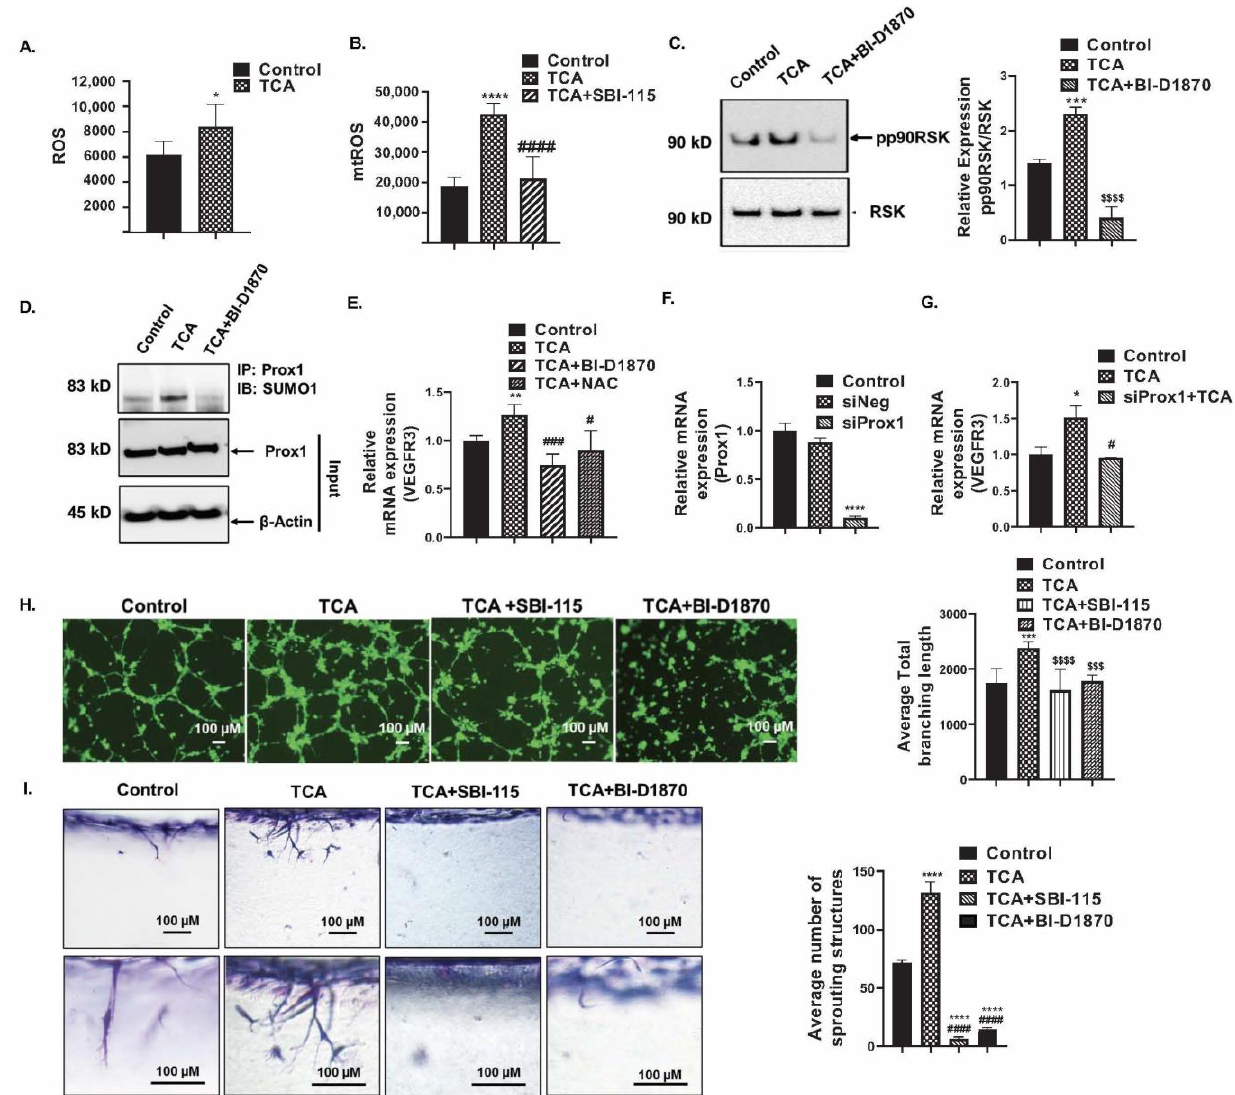
Figure 5. Conjugated BAs promote ROS production and induces p90RSK-mediated Prox1 SUMOy- lation and enhances VEGFR3. TCA (100 µM) induced ( A ) cellular ROS production at 45 min and ( B ) mtROS production after 12 h of treatment in HLEC, measured by fluorometric assay in plate reader. TGR5 antagonist SBI-115 (10 µM) pre-treatment for 1 h inhibited the TCA-induced mtROS produc- tion. ( C ) Western blot analysis showed that TCA (100 µM)-induced p90RSK phosphorylation in HLECs after 24 h, which was inhibited by p90RSK inhibitor BI-D1870. ( D ) After 24 h treatment with TCA (100 µM), the Prox1 was immunoprecipitated using anti-Prox1 antibody and probed with anti- SUMO1 antibody. TCA treatment induced Prox1 SUMOylation in HLECs which was inhibited by inhibition of p90RSK activation by using BI-D1870. ( E ) TCA (100 µM) induced VEGFR3 mRNA ex- pression which was inhibited by p90RSK inhibitor BI-D1870 and ROS inhibitor NAC. ( F ) Prox1 gene was knocked down in HLECs by siProx1 and ( G ) Prox1 knockdown inhibited the TCA-induced VEGFR3 expression. ( H ) TCA induced tube formation of HLECs in Matrigel at 4 h, which was in- hibited by the TGR5 antagonist SBI-115, p90RSK inhibitor BI-D1870. ( I ) TCA (100 µM) induced the HLEC invasion in 3D collagen matrix at 20 h and was inhibited by BI-D1870 or TGR5 antagonist SBI-115. Values represent mean ± SD n ≥ 3. Statistical analysis was done by ANOVA followed by Fishers LSD. *, **, ***, **** indicates p ≤ 0.05, p ≤ 0.01, p ≤ 0.001, p ≤ 0.0001, respectively, as compared to respective control., $$$, $$$$ indicates p ≤ 0.001, p ≤ 0.0001, respectively, as compared to TCA. #, ###, #### indicates p ≤ 0.05, p ≤ 0.001, p ≤ 0.0001, respectively, as compared to TCDCA.